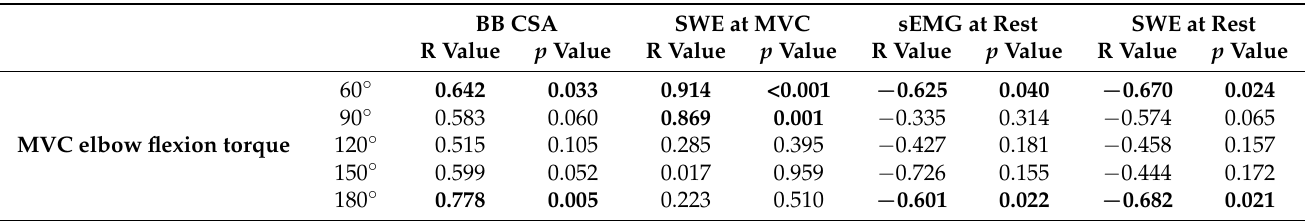
Table 4. Pearson correlation test findings for the maximum voluntary elbow flexion torque. BB CSA